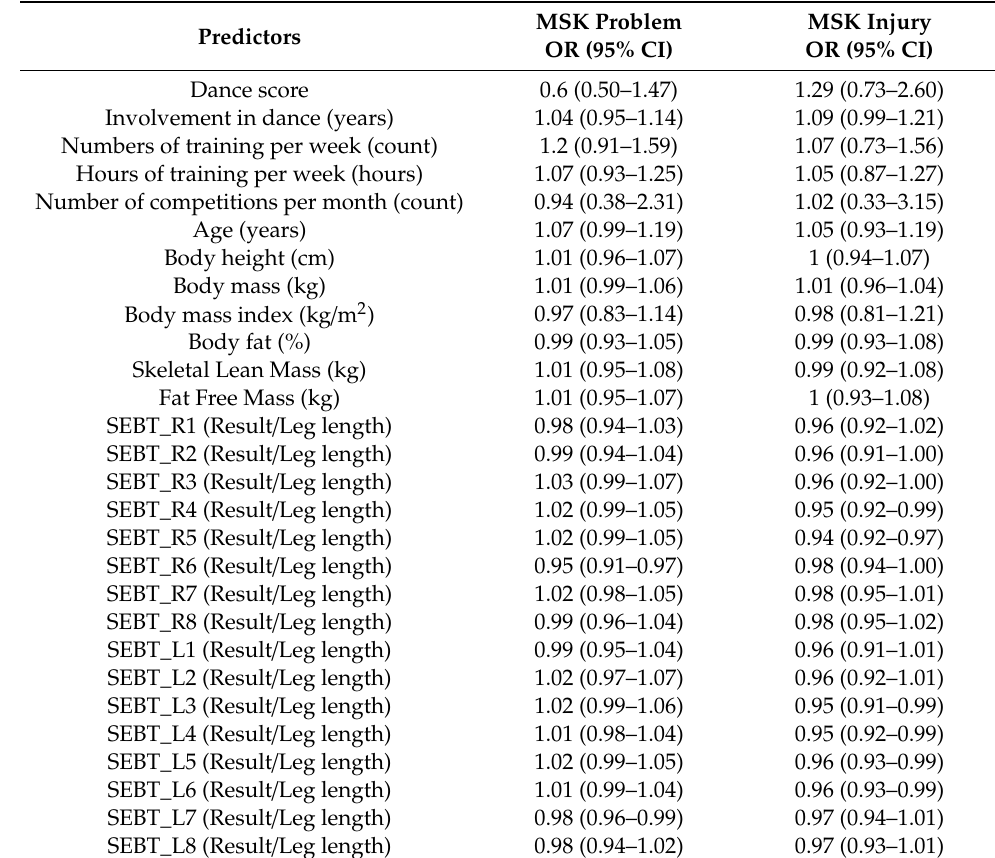
Table 3. Correlates of musculoskeletal (MSK) injury and problem in hip hop dancers as obtained by Oslo Sports Trauma Research Center Overuse Injury Questionnaire—crude (non-adjusted) multinomial regression univariate correlations between predictors and criteria (“no MSK problem / injury” as reference value).